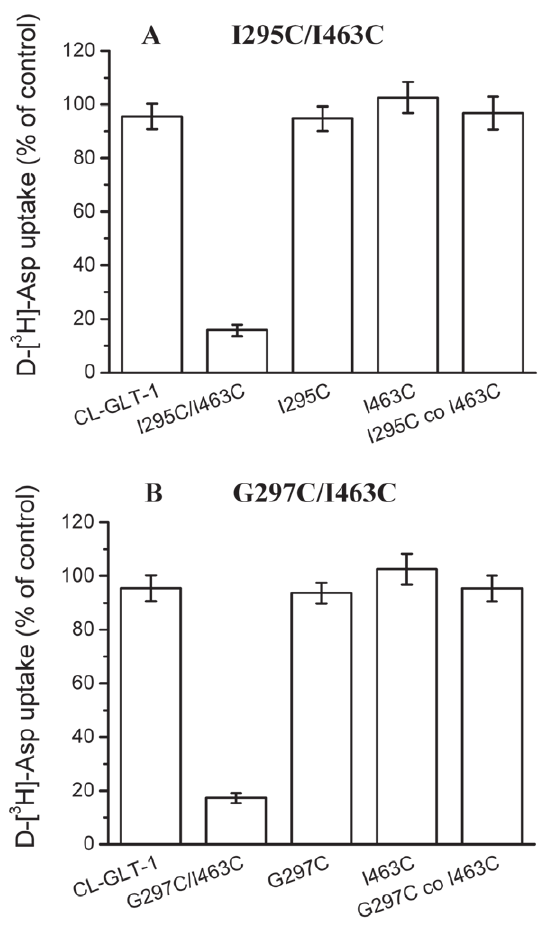
Figure 3. Inhibition of transport of cysteine mutants by Cd 2 + . HeLa cells expressing the indicated mutants were washed once with choline chloride-containing solution and assayed for transport in the presence or absence of 500 m M cadmium chloride. Values shown are the percentage activity in the presence of 500 m M cadmium chloride relative to that in its absence. Values represent the mean 6 S.E. of at least three separate experiments each done in triplicate. ( A ) I295C/ I463C double cysteine mutants and its control mutants. ( B ) G297C/ I463C double cysteine mutants and its control mutants.